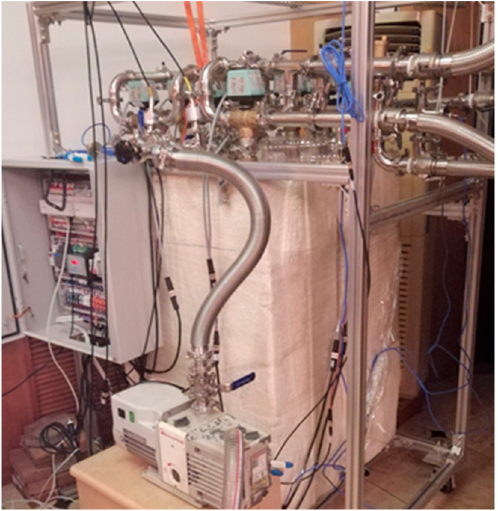
Figure 9. Photo of the prototype currently being tested at Tianjin, China.